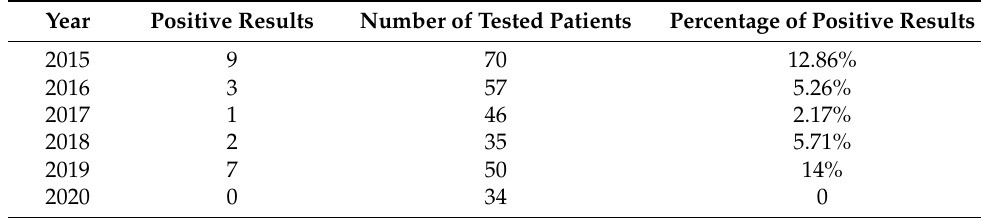
Table 11. Candida mannan antigen in PCICU patients.